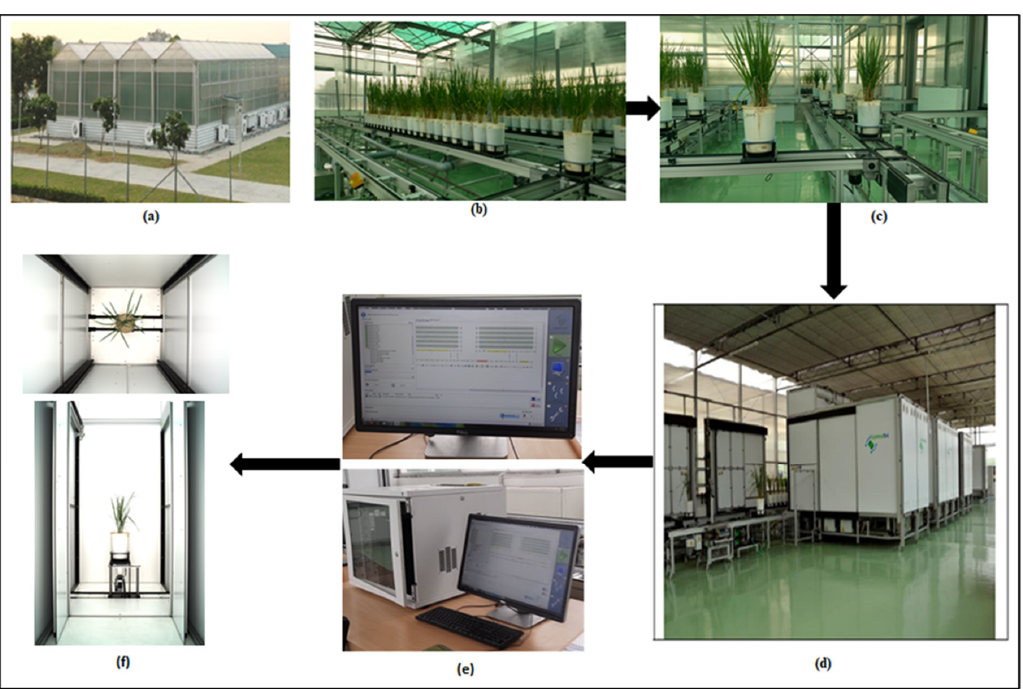
Figure 1. A plant-to-sensor type, high throughput plant phenotyping facility at Nanaji Deshmukh Plant Phenomics Centre (NDPPC), Indian Council of Agricultural Research–Indian Agricultural Research Institute, and their different components for the experimental setup, representing a general workflow: ( a ) NDPPC, external view; ( b ) rice plants in pots, transplanted inside the climate-controlled greenhouse; ( c ) rice plants are transported on carriages to the imaging chamber; ( d ) automatic imaging chambers, each chamber is equipped with a different sensor of interest, in this case, RGB; ( e ) monitoring and work station equipped with software; ( f ) image of a rice plant, top view and side view of the rice plant after